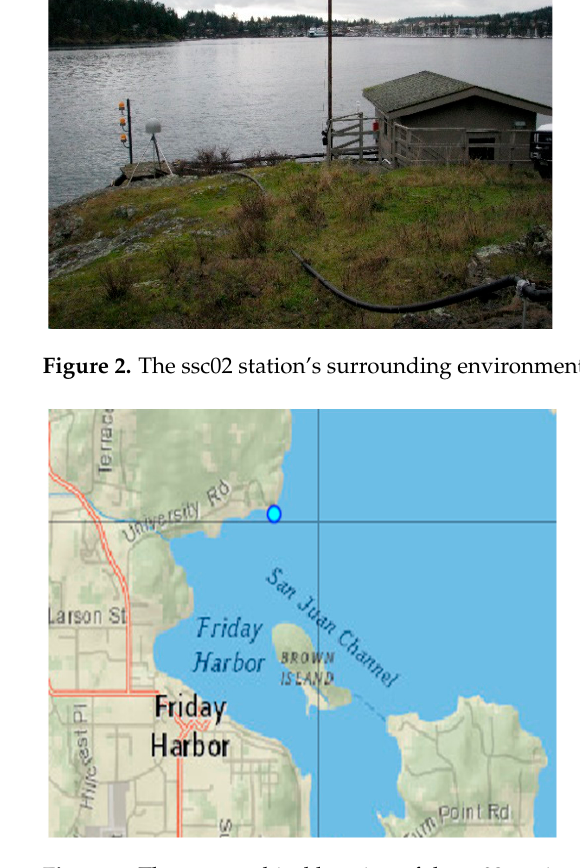
Figure 4. Periodic diagram ( a ) The triple-frequency combined - phase observation and ( b )the Lomb- Scargle spectrum; sin e is the sinusoidal value of the satellite altitude angle e . The tide level inversion model is established based on the satellite observation data and the tide level data for 15 consecutive days from 1 August 2020 to 15 August 2020. The effective inversion height h is calculated by subtracting the tide level height solution from the height h of the antenna phase center. Through the spectrum analysis of the triple- frequency combined-phase observation values, the frequency f is obtained, and then the primary model of the effective reflection height and frequency f is established. Figure 5 shows a model between the height from the antenna phase center to the reflecting surface and the frequency of the combined phase observation which is obtained